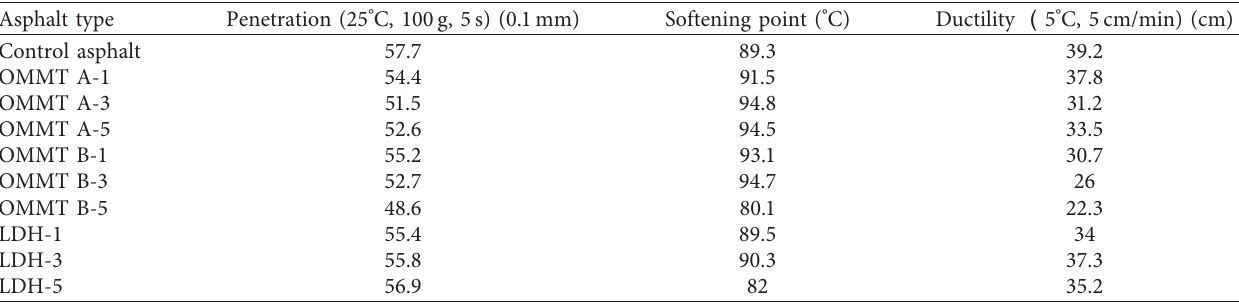
Table 5: Basic performances of the asphalts.